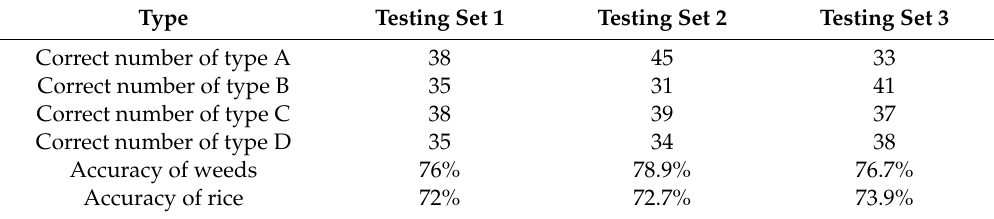
Table 6. Network accuracy results for group